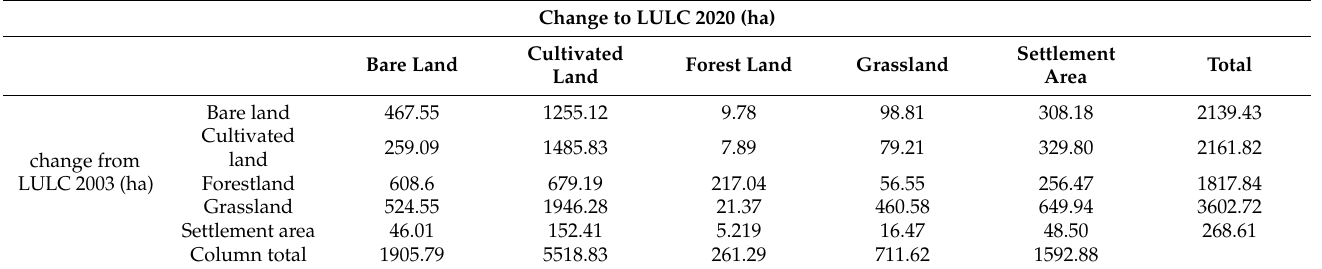
Table 7. LULC change matrices of the Matenchose watershed